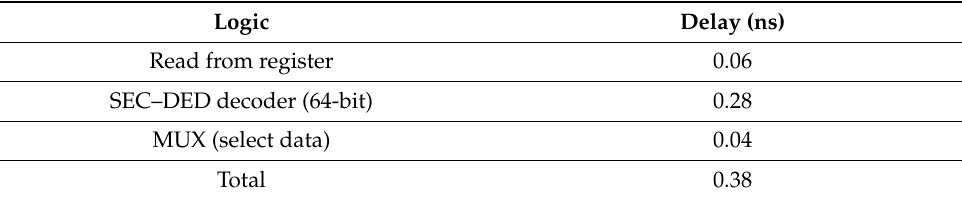
Table 7. Data read path stage 1 timing of the high-performance